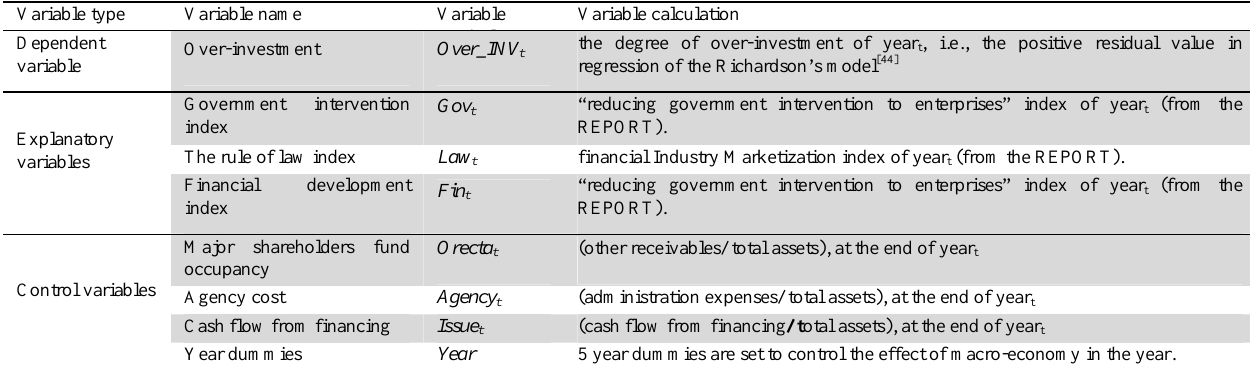
Variables setting and calculation in Model